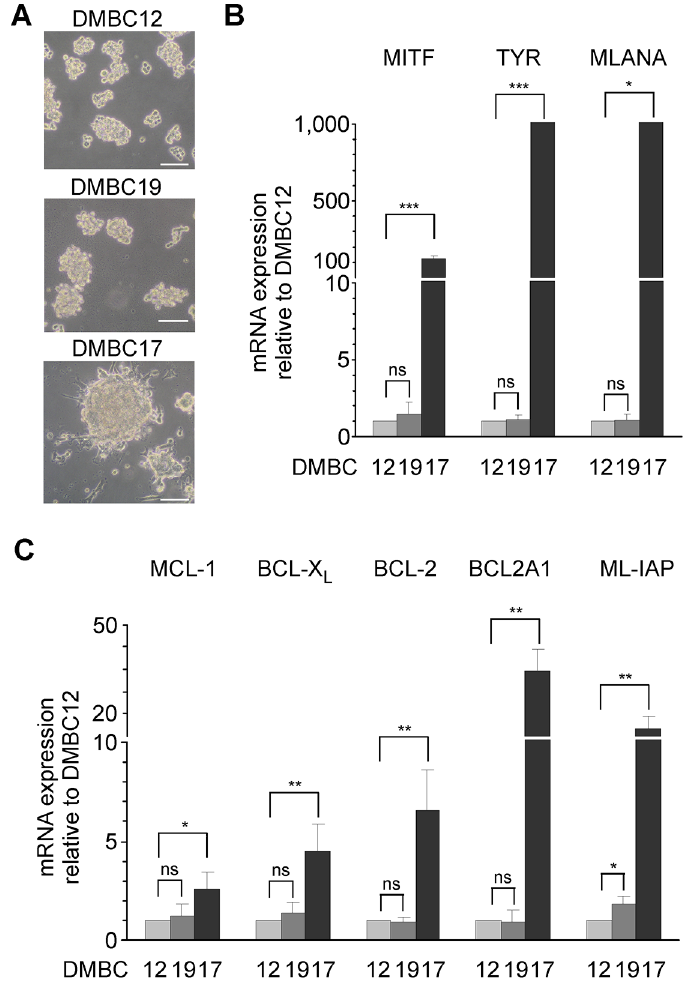
Fig 1. Characteristics of patient-derived cultures used in this study. (A) Morphology of melanoma cells grown in EGF(+)bFGF(+) medium. Fast growing populations DMBC12 and DMBC19 formed cell aggregates, whereas slow growing DMBC17 population formed more dense melanospheres. Scale bar, 100 μ m. (B) qRT-PCR was used to assess the expression of MITF and MITF-dependent genes in melanoma cultures in EGF(+)bFGF(+) medium. Data are presented as the means ± SD (n = 4). A fold change more than 1,000 is shown as 1,000. * p < 0.05; *** p < 0.001; ns, p > 0.05. (C) qRT-PCR was used to assess the expression of pro- survival genes in melanoma cells grown in EGF(+)bFGF(+) medium. Data are presented as the means ± SD (n = 4). * p < 0.05; ** p < 0.01; ns, p >